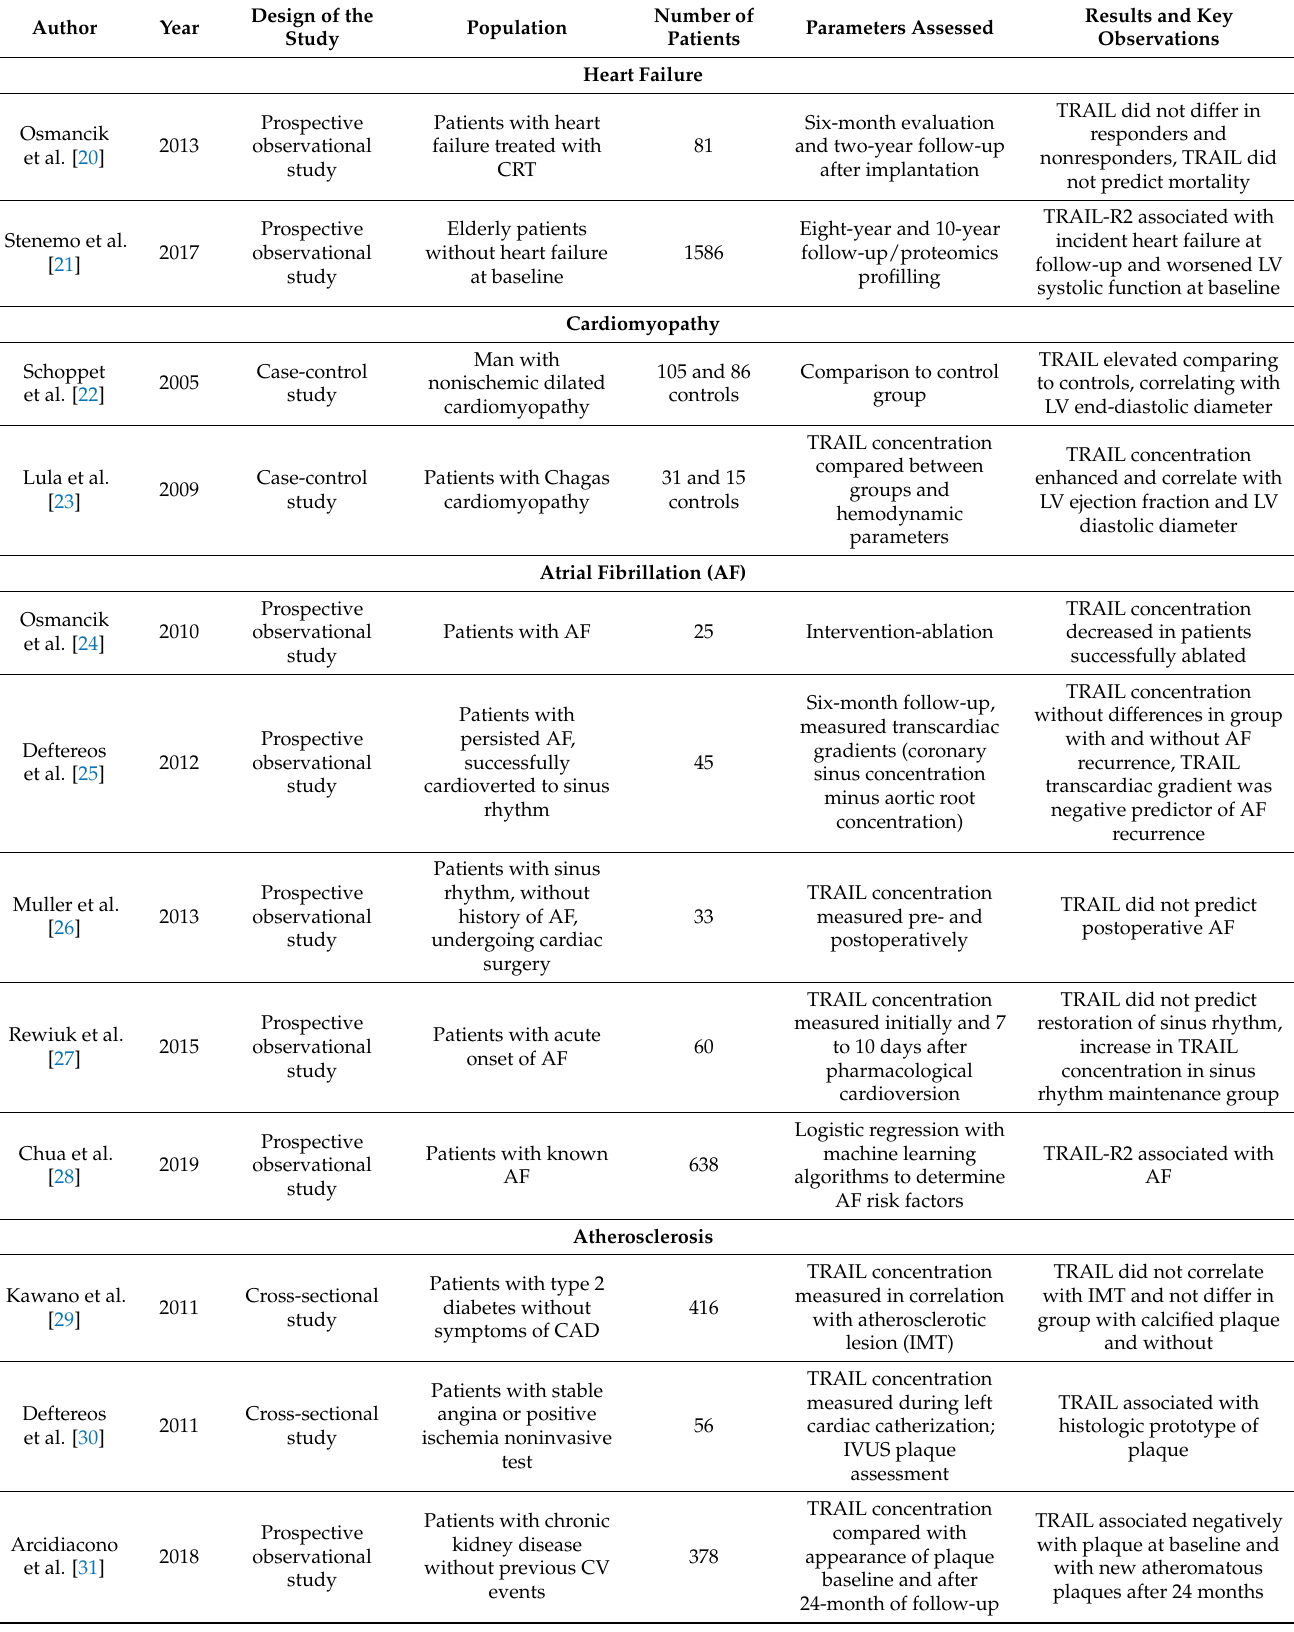
Table 1. Original Studies Assessing the Relationship between TRAIL and TRAIL-R2 and Cardiovascular